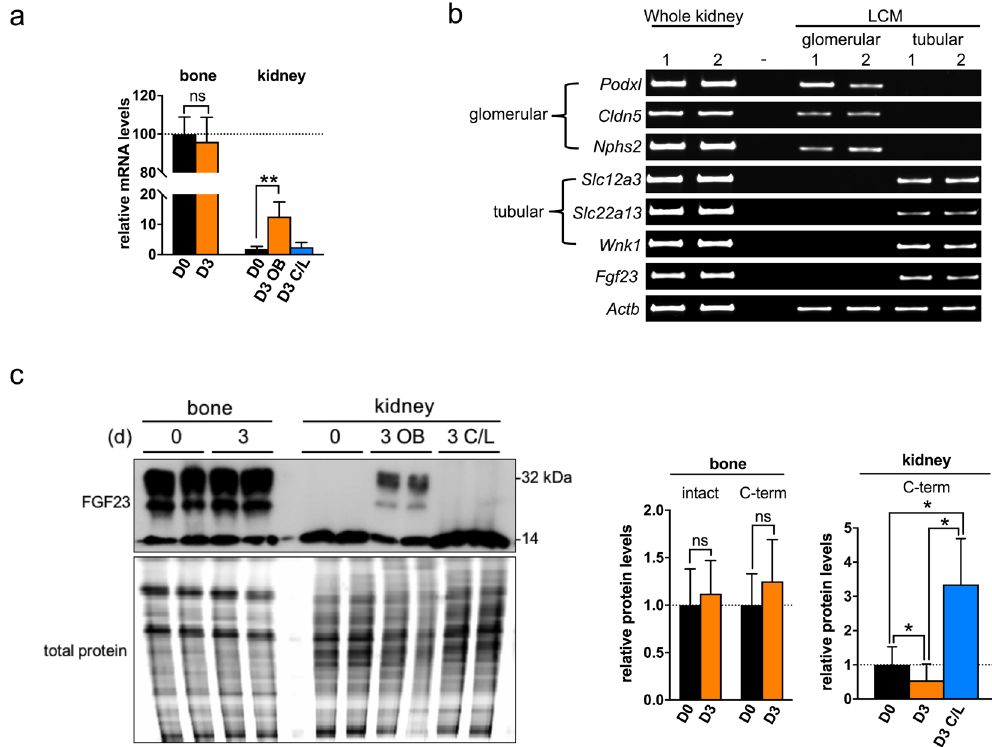
Figure 3. Acute tubulointerstitial injury induces de novo tubular FGF23 expression. ( a ) qRT-PCR analysis of FGF23 gene expression in both hind limb bone (D0, D3) and kidney tissue. Results are expressed relative to the bone transcript levels ( = 100) in D0 animals (n = 4 mice for each group). ( b ) RT-PCR detection of Fgf23 and glomerular- and tubular-enriched transcripts in whole kidney homogenates and laser capture microdissected isolates from D3 OB tissue (n = 2 animals). Glomerular-enriched transcripts were podocalyxin-like protein 1 ( Podxl ), claudin 5 ( Cldn5 ) and podocin ( Nphs2 ). Tubular -enriched transcripts were solute carrier family 12 member 3 ( Slc12a3 ), solute carrier family 22 member 3 ( Slc22a13 ), and serine/threonine-protein kinase WNK1 ( Wnk1 ). β -actin ( Actb ) was used a positive control. ( c ) Representative Western blot analysis of FGF23 protein expression in both hind limb bone (D0, D3) and kidney. Antibody detects both full-length intact FGF23 (32 kDa) and C-terminal FGF23 fragment (14 kDa). Total protein was used as a loading control. Densitometric quantitation of the intact and C-terminal FGF23 ratios normalised ( = 1.0) to control D0 levels in bone and C-terminal FGF23 levels in kidney extracts are shown alongside (n = 4 mice for each group). Quantitation of intact FGF23 levels in kidney was not performed due to the very low levels detected. Data are shown as mean ± SD. * P < 0.05; ** P < 0.01; ns, not significant. P-values were determined in ( a , c ) by one-way ANOVA with Holm-Sidak multiple comparisons